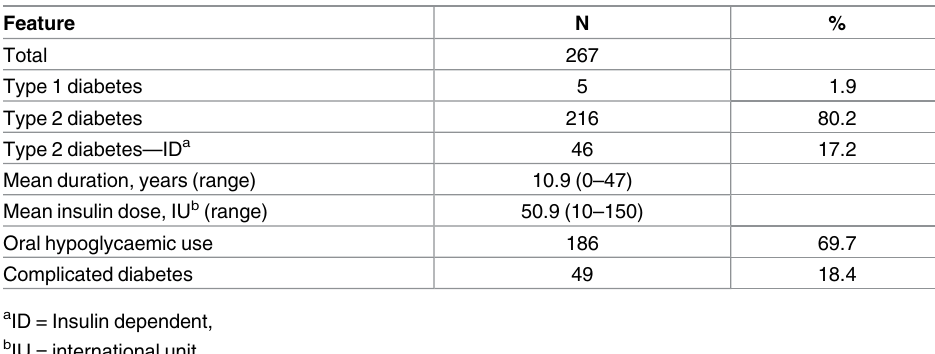
Table 2. Characteristics of diabetic patients.